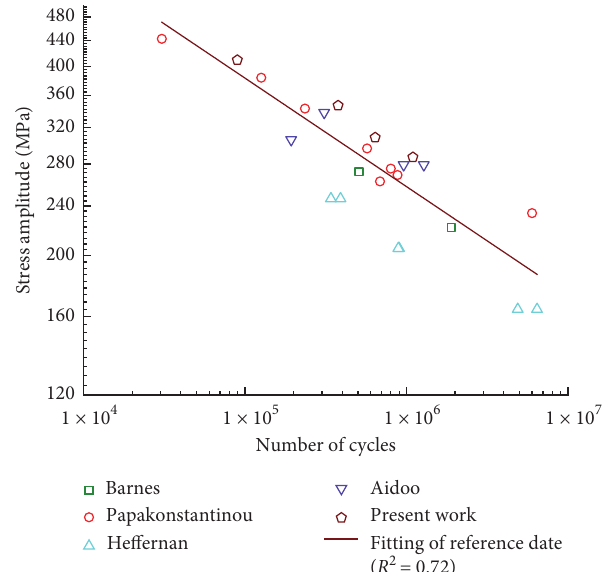
Figure 10: Steel stress amplitude versus cycle number in loga- rithmic